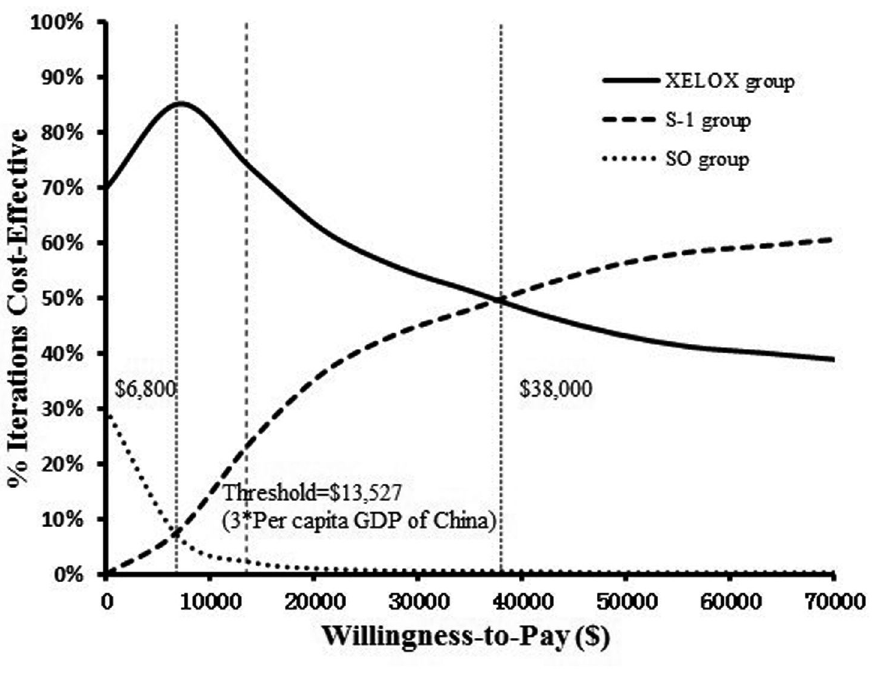
Figure 6. Acceptability curves for the choice of three treatment strategies at different willingness-to-pay (WTP) thresholds in Chinese resectable gastric cancer patients. Three vertical dashed lines represent different WTP thresholds. doi: